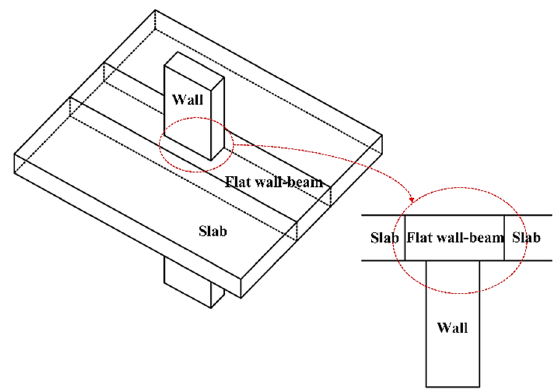
Figure 3. Wall-slab joints in TWTS structures.